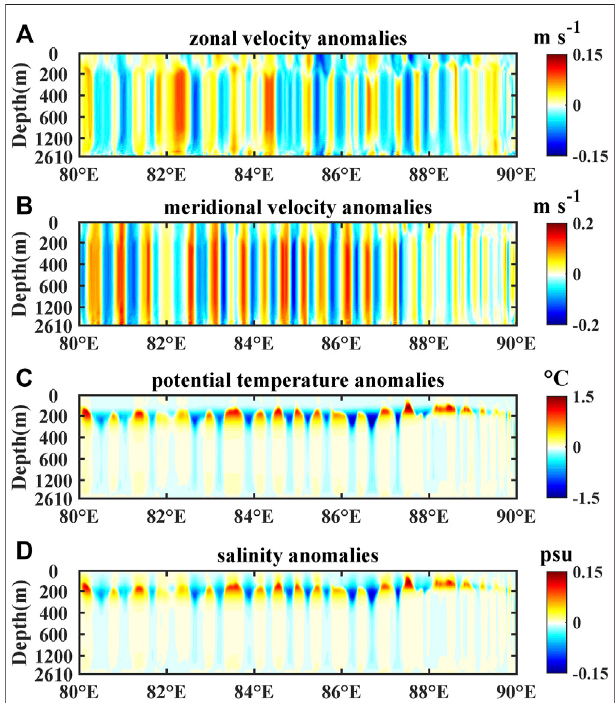
FIGURE 3 | (A) A snapshot of the zonal cross-section (65.7 ° S) of the zonal velocity anomalies (m s − 1 ) at the lower continental slope (sea fl oor depth is 2,610 m). (B – D) Same as (A) , but for the meridional velocity anomalies (m s − 1 ), the potential temperature anomalies ( ° C), and the salinity anomalies (psu), respectively.